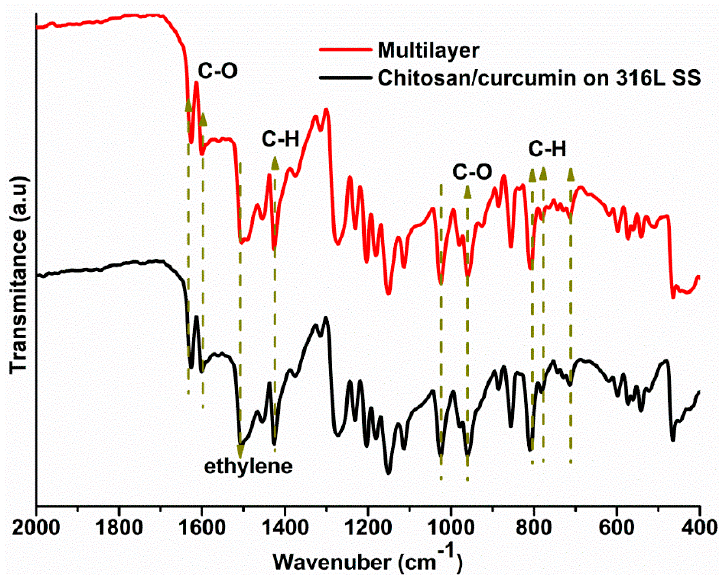
Figure 8. FTIR spectra of chitosan / curcumin coatings on SS and on PEEK / BG / h-BN layers (multilayer) produced by EPD.